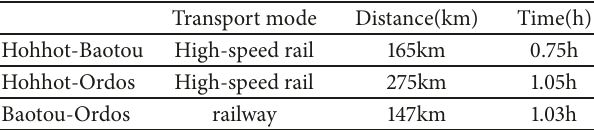
Table 5: Distance between center cities (hour). Transport